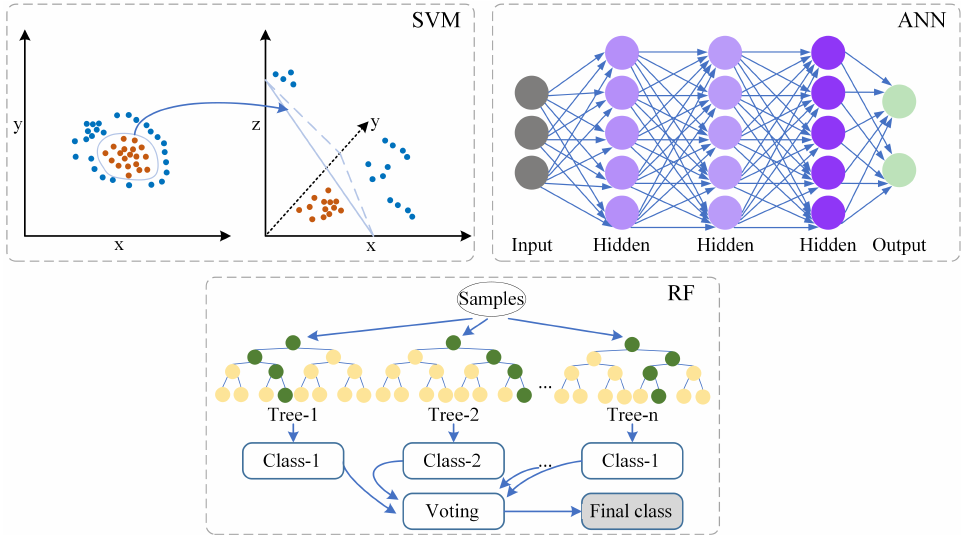
Figure 3. The supporting vector machine (SVM), artificial neural network (ANN), and random forest (RF)